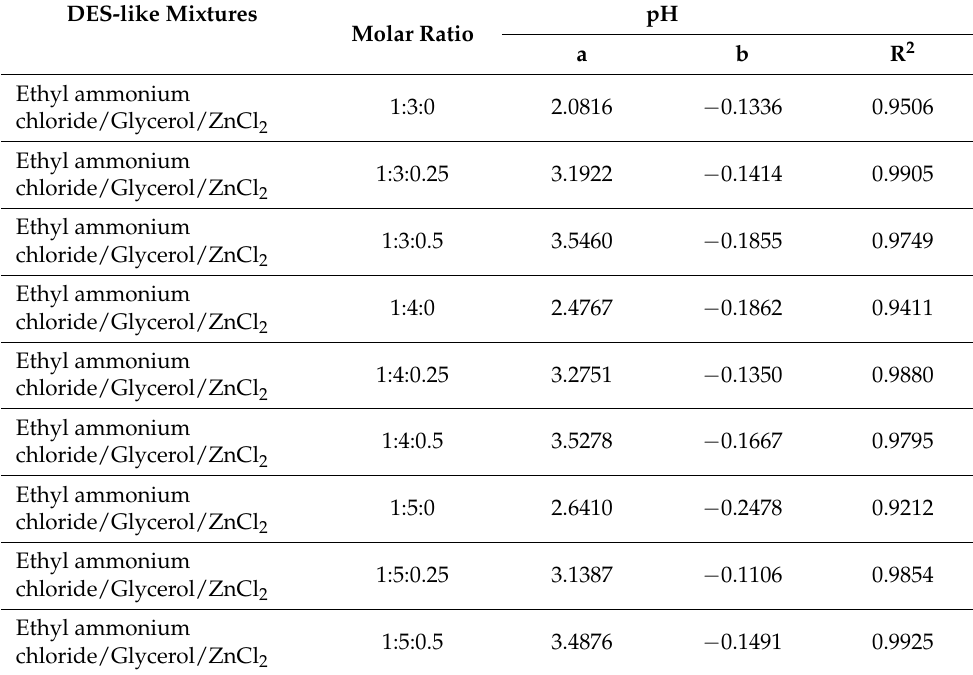
Table 8. Values of constants a and b for Equation (3) (adapted according to Saputra et al.) [33]. DES-like Mixtures